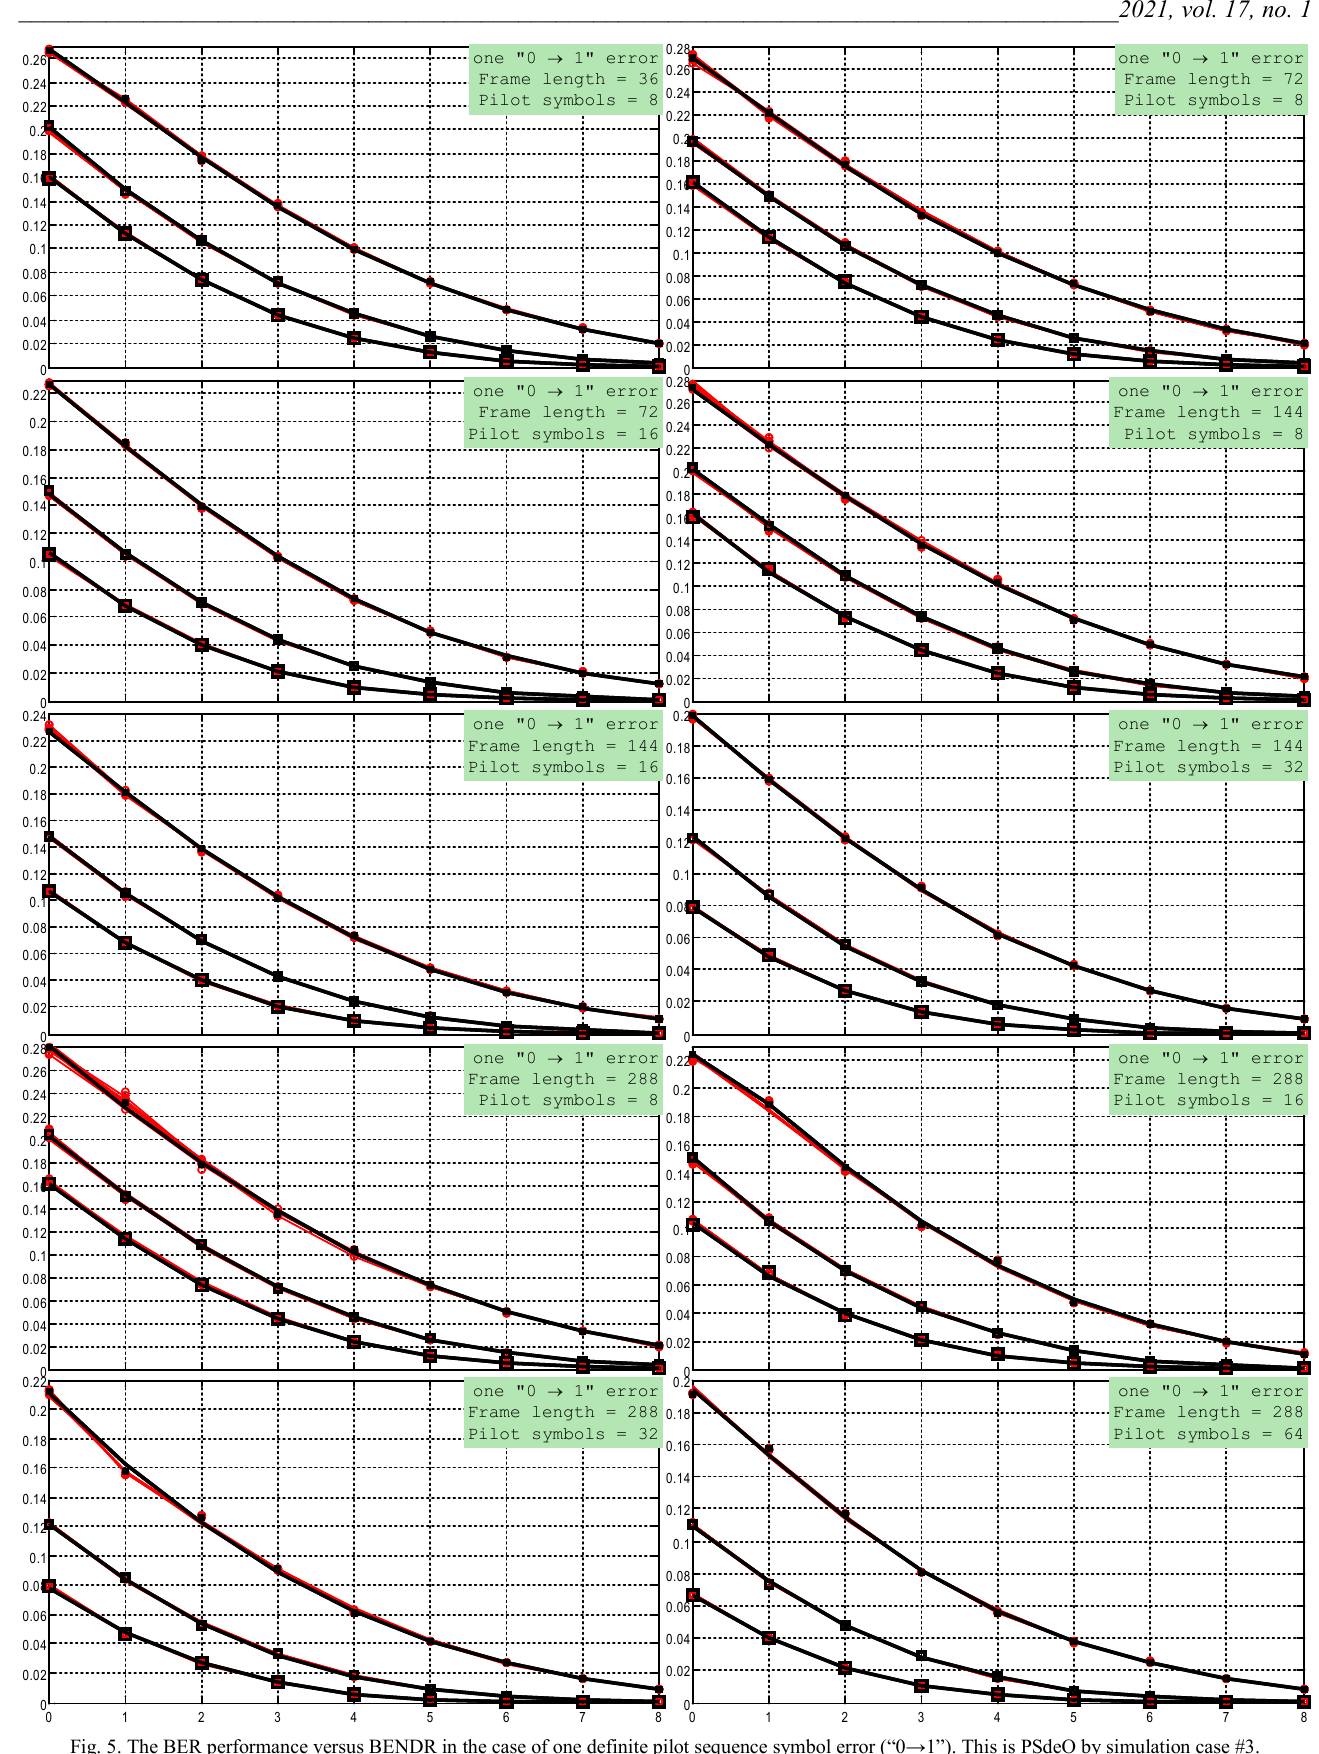
Fig. 5. The BER performance versus BENDR in the case of one definite pilot sequence symbol error (“0→1”). Thi s is PSdeO by simulation case